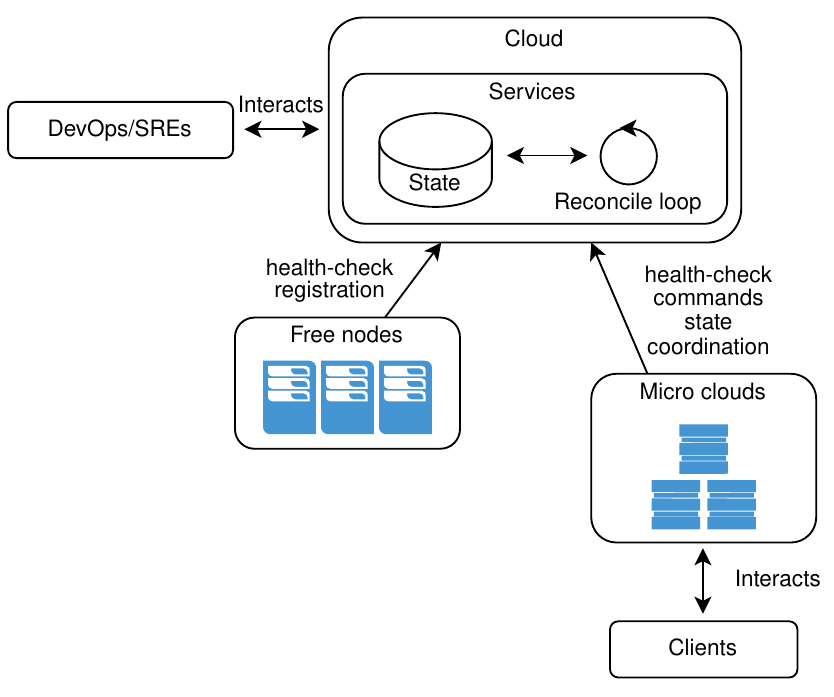
Figure 3. High level architecture of the